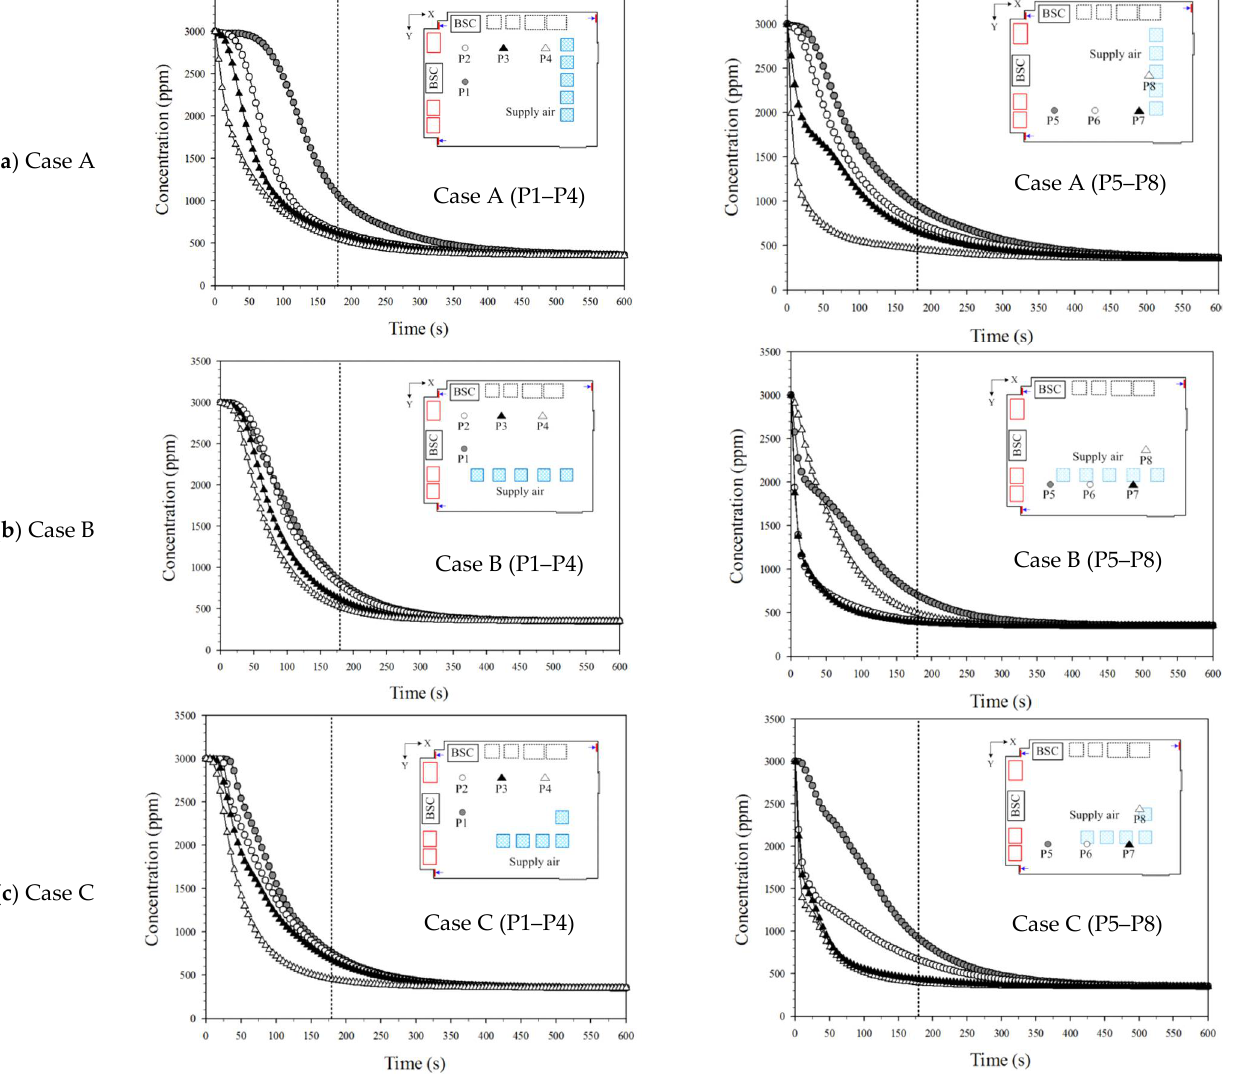
Figure 11. Contamination control performance for different supply air arrangements.